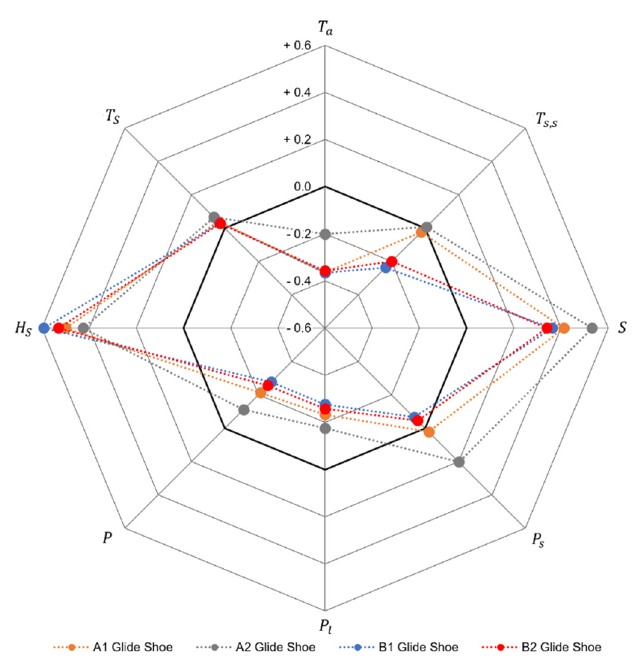
Figure 5. Correlation analysis of gliding speed, U , against chosen variables: air temperature, T a , interface temperature, T s , s , soil water content, S , solid precipitation, P s , liquid precipitation, P l , total precipitation, P , snow depth, H S and snow temperature, T S